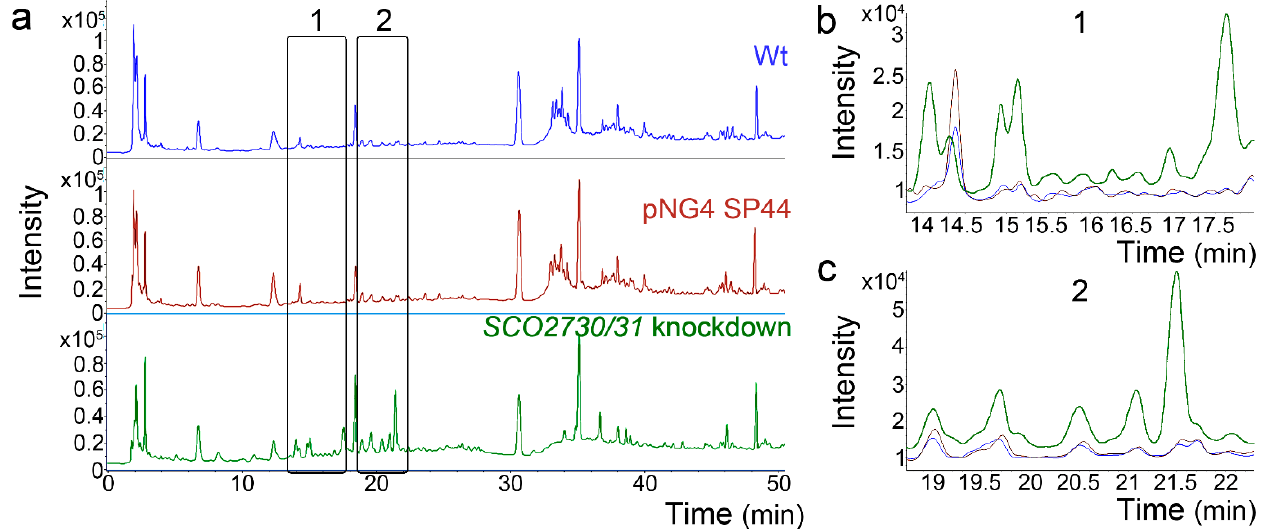
Figure 7. HPLC-DAD chromatograms of the S. albus SCO2730/31 knockdown mutant compared to the S. albus wild-type strain with and without pNG4-SP44. ( a ) Whole chromatograms. The rectangles mark the clearest differences between the SCO2730/31 knockdown mutant and the wild-type strain with or without pNG4-SP44. ( b , c ) Magnifications of the chromatogram areas marked with rectangles. Only one biological replicate is shown.